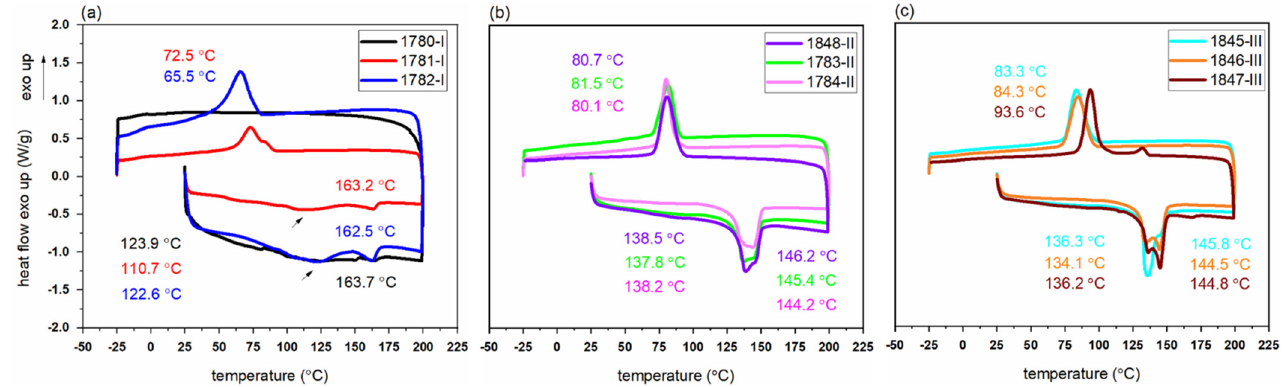
Figure 7. First DSC heating/cooling cycles of PHBH monofilaments produced from polymer grade ( a ) I ( b ) II ( c ) III.